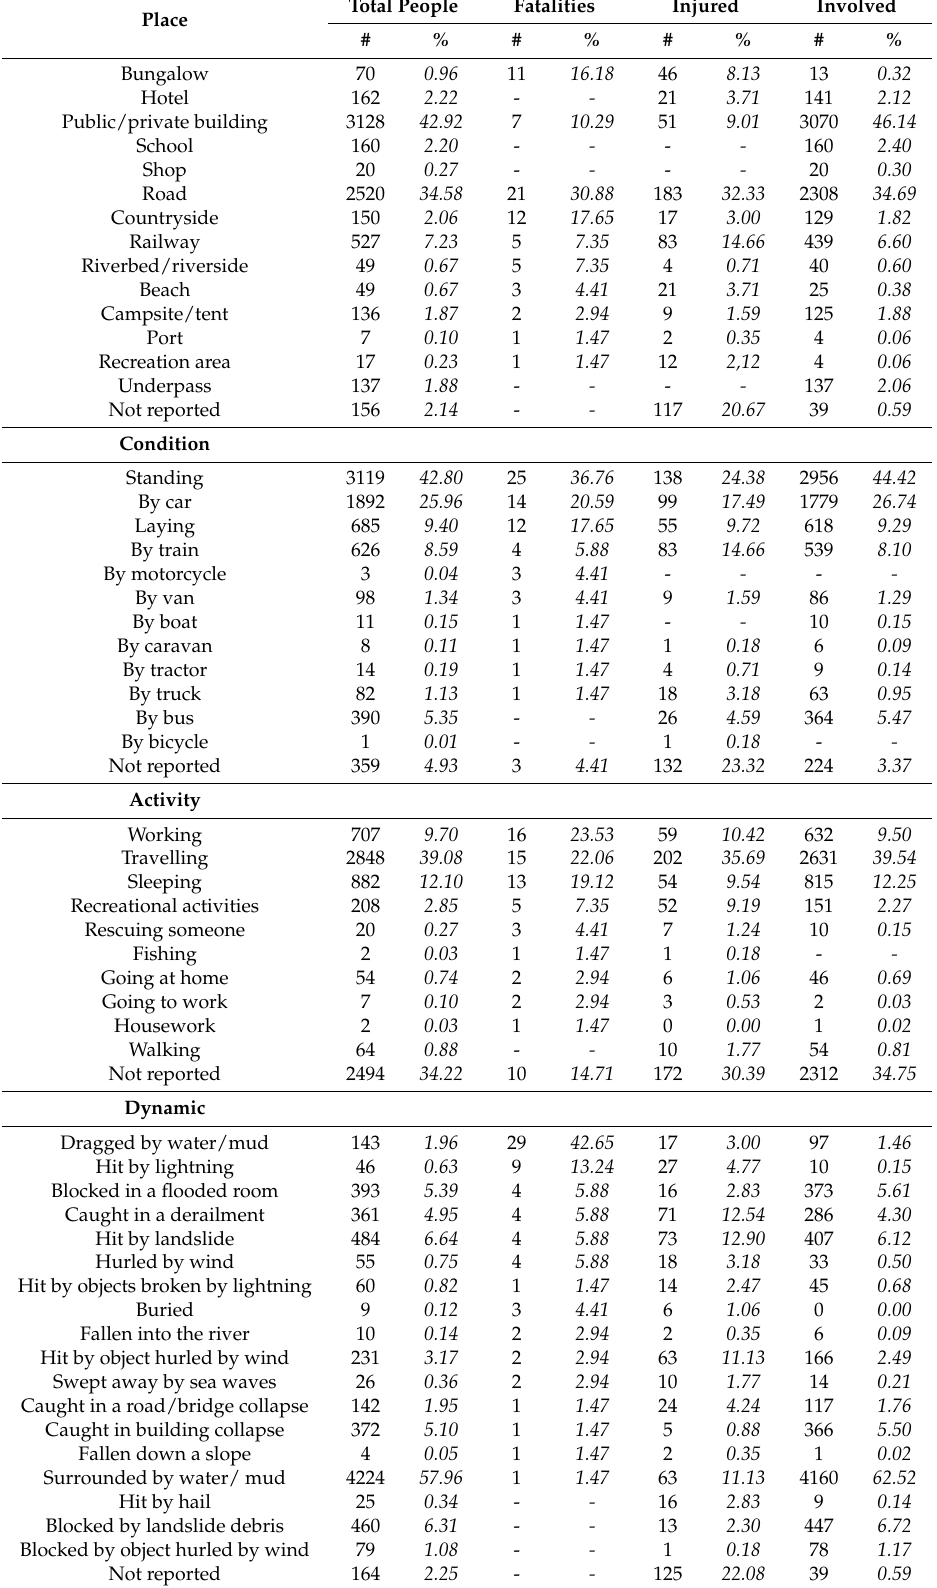
Table A2. Place, condition, activity and